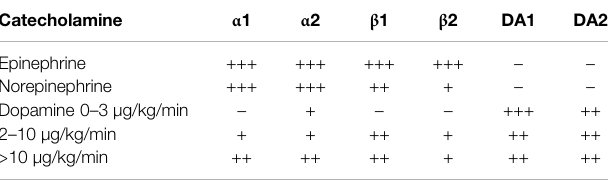
TABLE 3 | Adrenergic receptor selectivity of endogenous catecholamines.